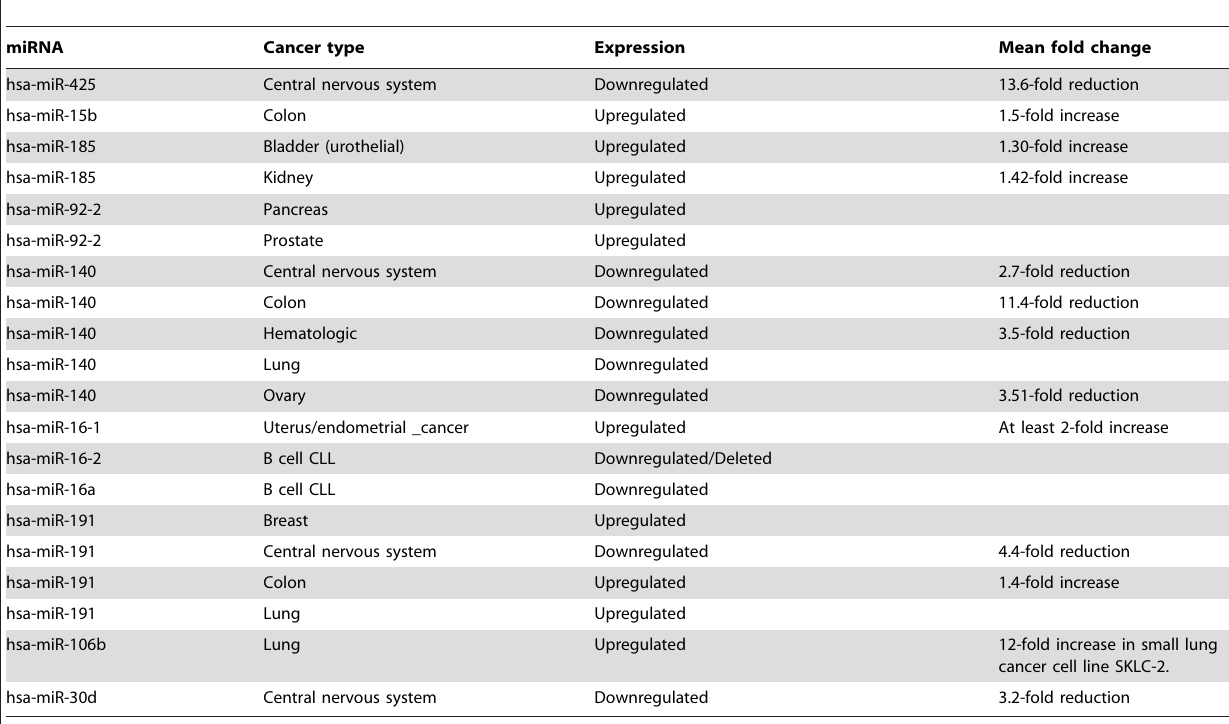
Table 4. miRNAs in Table 2 whose up- and/or downregulation in any cancer was reported in the study by Bandyopadhyay et al.